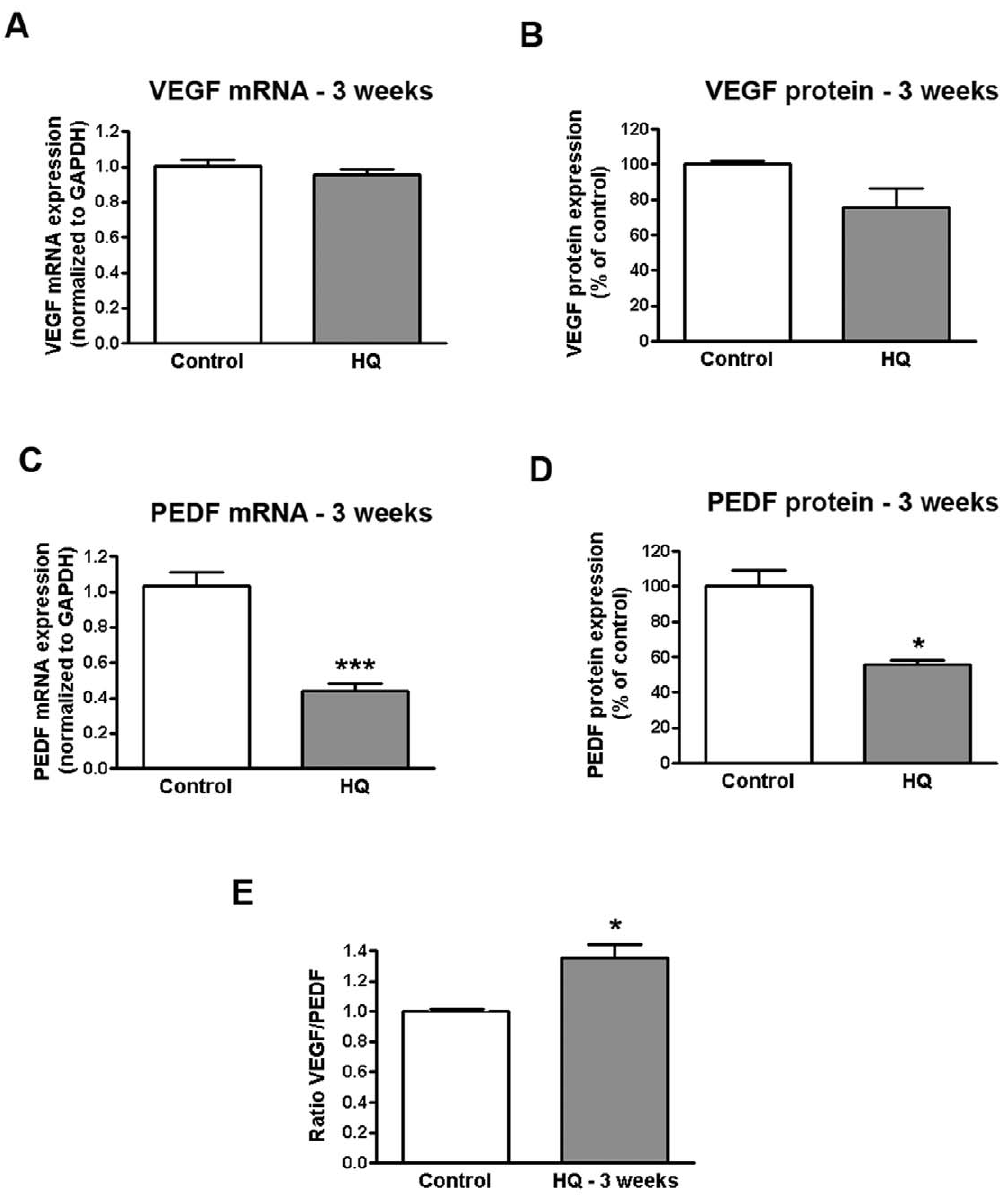
Figure 6. Increased VEGF-to-PEDF ratio in human RPE cells following repetitive oxidative injury with HQ. Confluent serum-starved ARPE-19 cells were treated with 50 m M HQ every 4 days for 24 hours for 3 consecutive weeks in phenol red-free 0.1% FBS medium. Total RNA was extracted to assess ( A ) VEGF and ( D ) PEDF mRNA expression by real-time PCR. GAPDH was used as internal control. Supernatants were collected to assess ( B ) VEGF and ( D ) PEDF protein concentration by ELISA. ( E ) VEGF-to-PEDF protein ratio. Data are mean 6 SE and represent the average results of 3 independent experiments run in duplicate. * is p , 0.05 and *** is p , 0.0001 versus control.